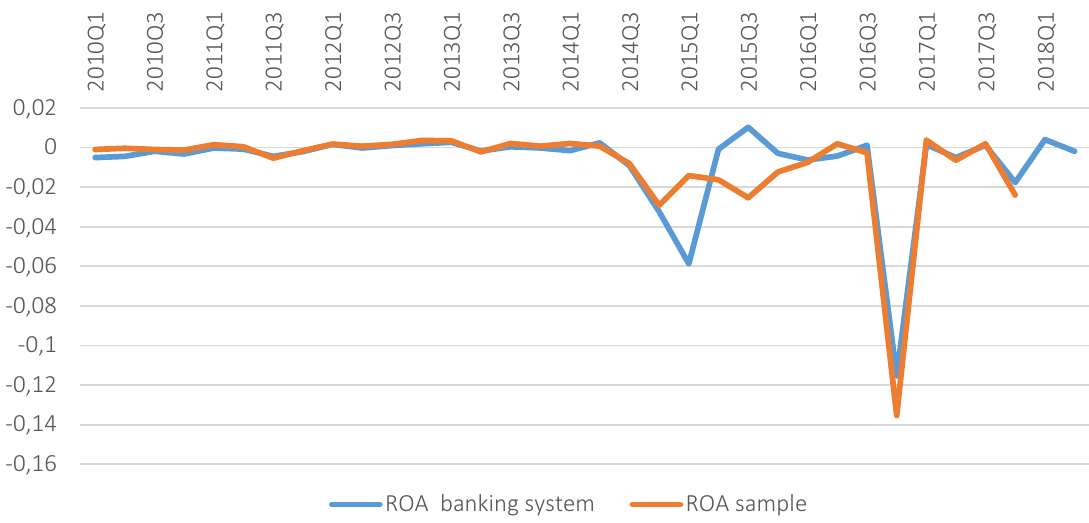
Figure 1. Return on assets over the period of